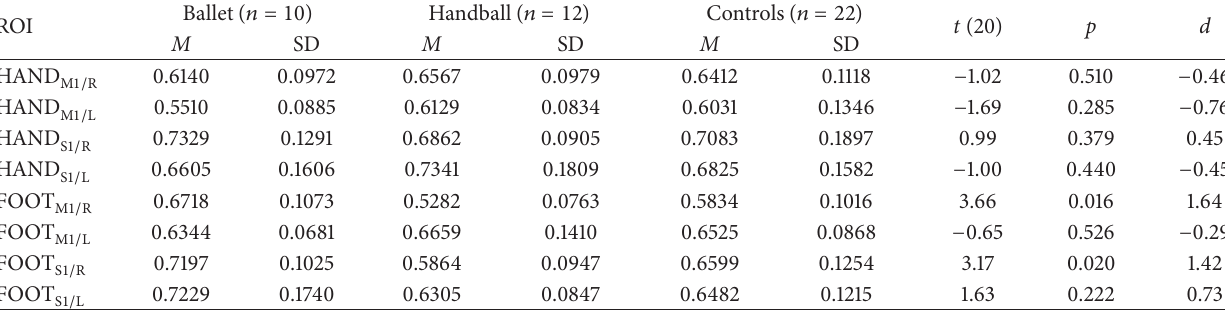
Table 3: Group comparisons of cortical volume (GM) in each region of interest (ROI).